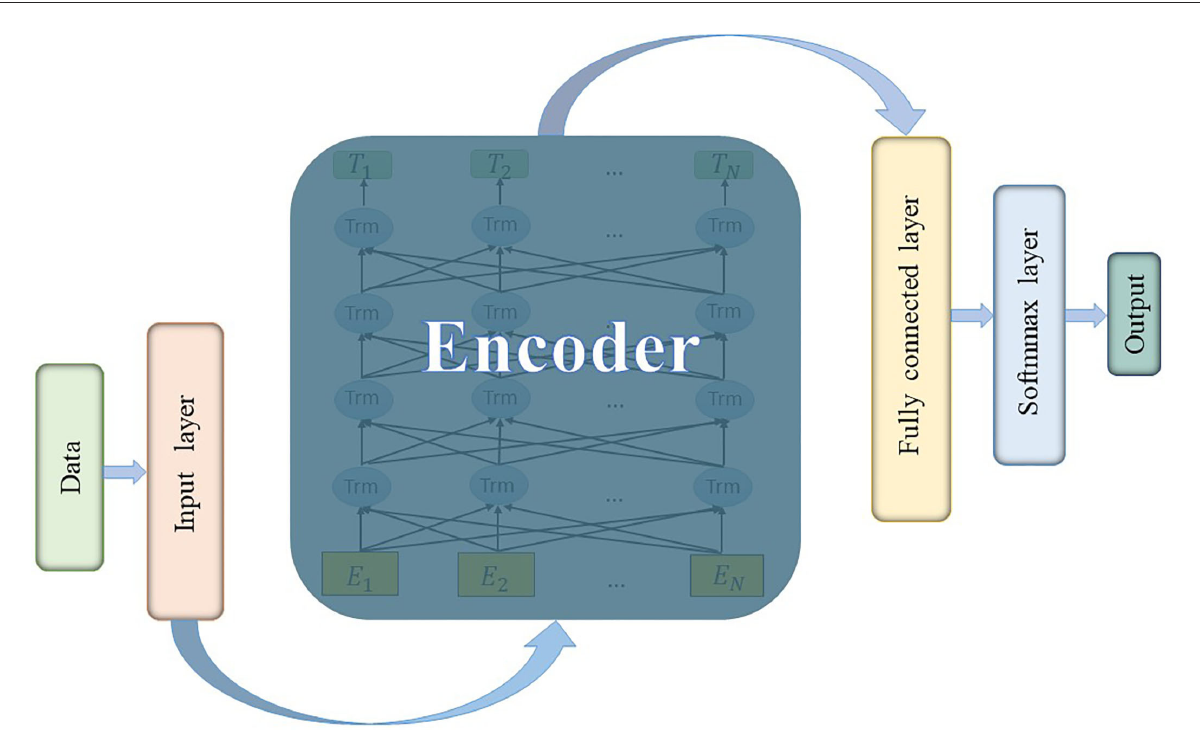
FIGURE1 The architecture of BERT